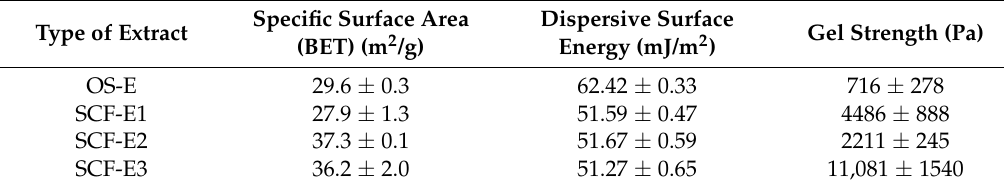
Table 3. Surface characterisation of birch bark extract obtained by different extraction methods. Type of